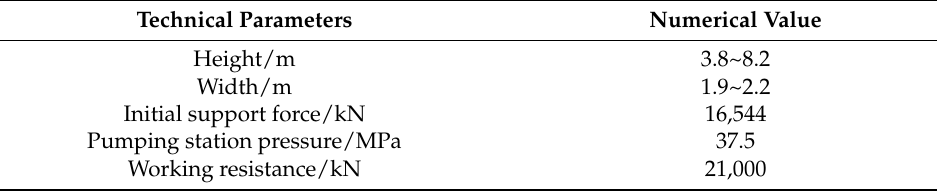
Table 2. Technical parameters of two-column hydraulic support.